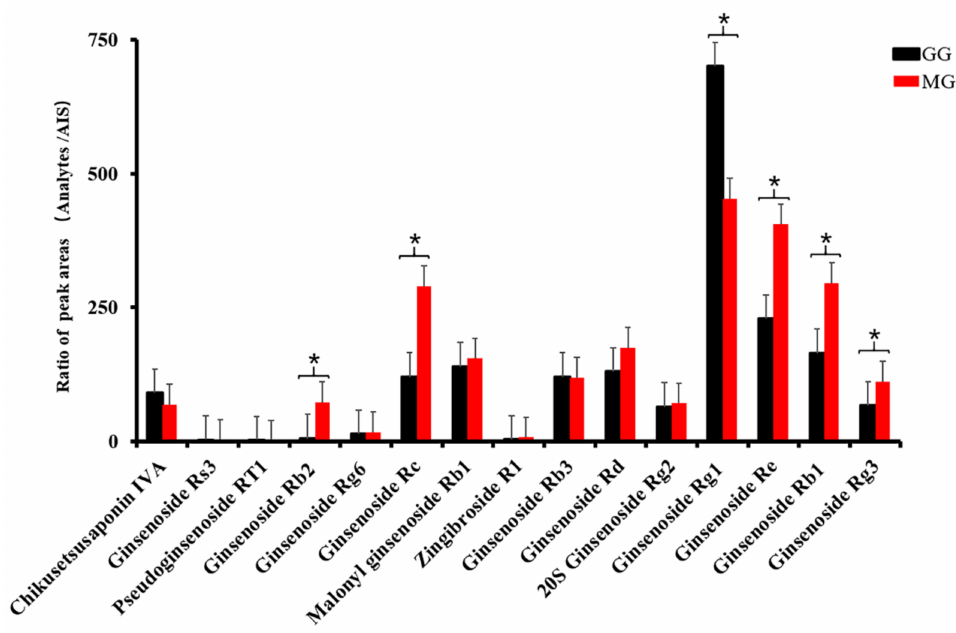
Figure 4. t -test analysis results of the 15 identified components (* p <